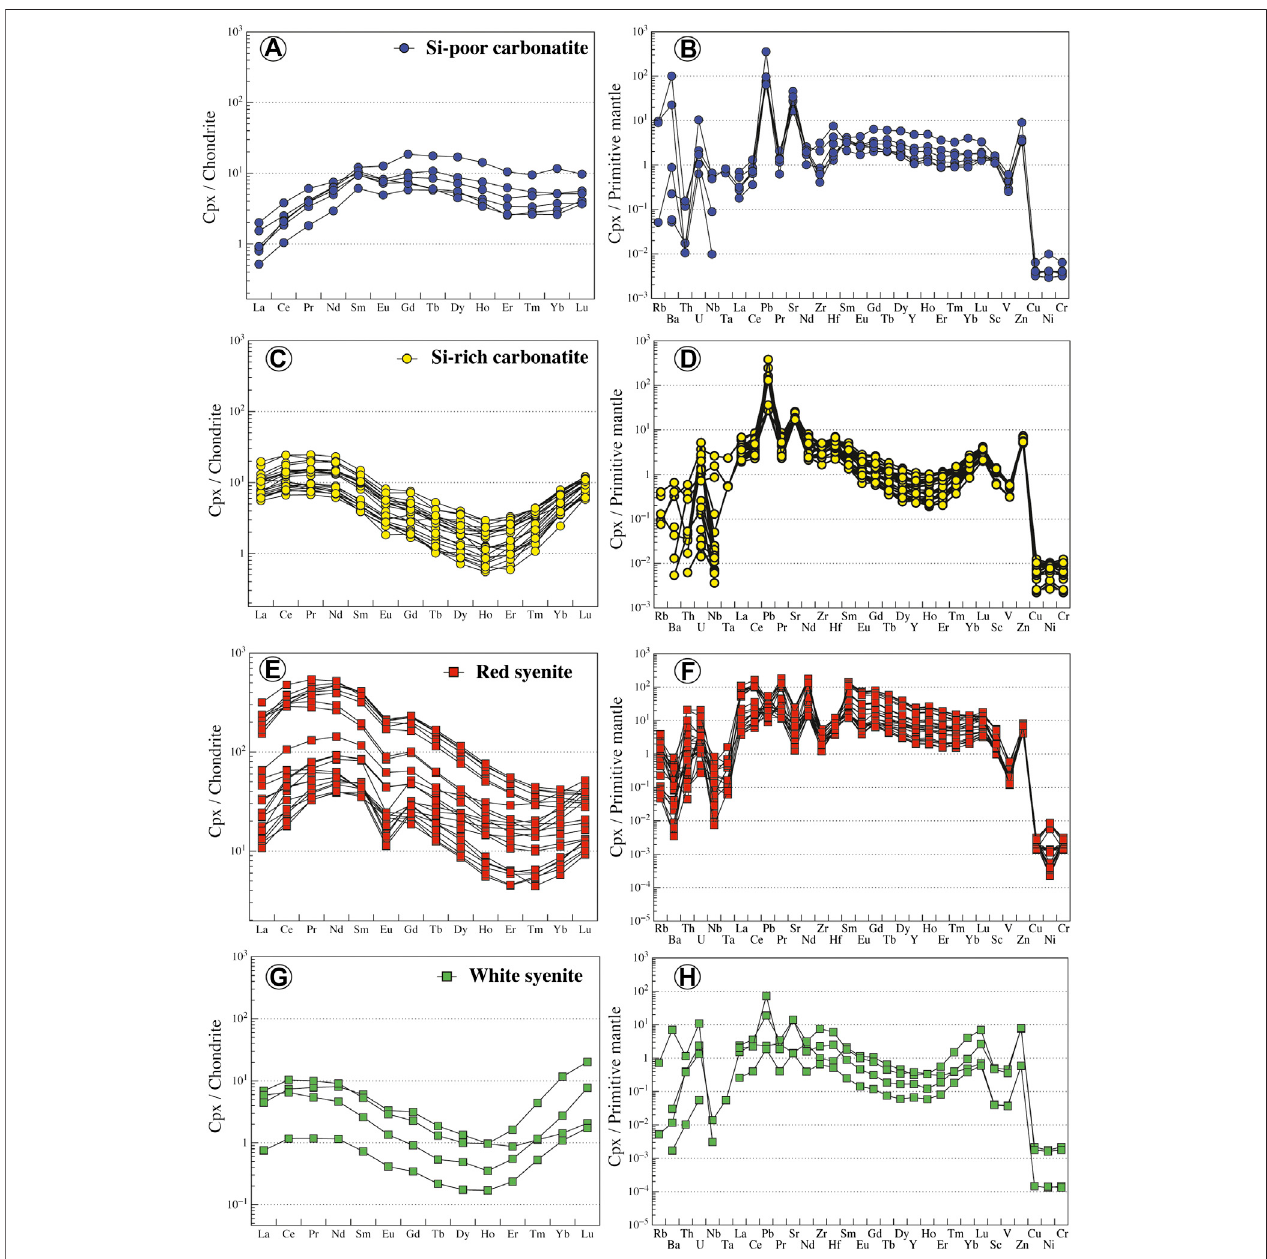
FIGURE 8 | Normalized REE and trace element contents of clinopyroxene from Ihouhaouene carbonatites and associated silicate rocks. Chondrite values and primitive mantle values are obtained from Sun and McDonough (1989).